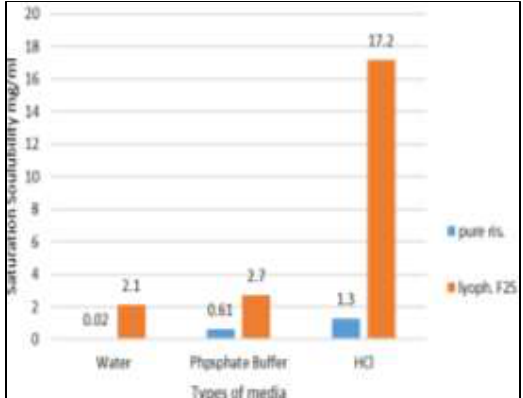
Figure 8. Solubility of lyophilized F13 in distilled water, phosphate buffer pH 6.8 and 0.1N 0.1N HCl